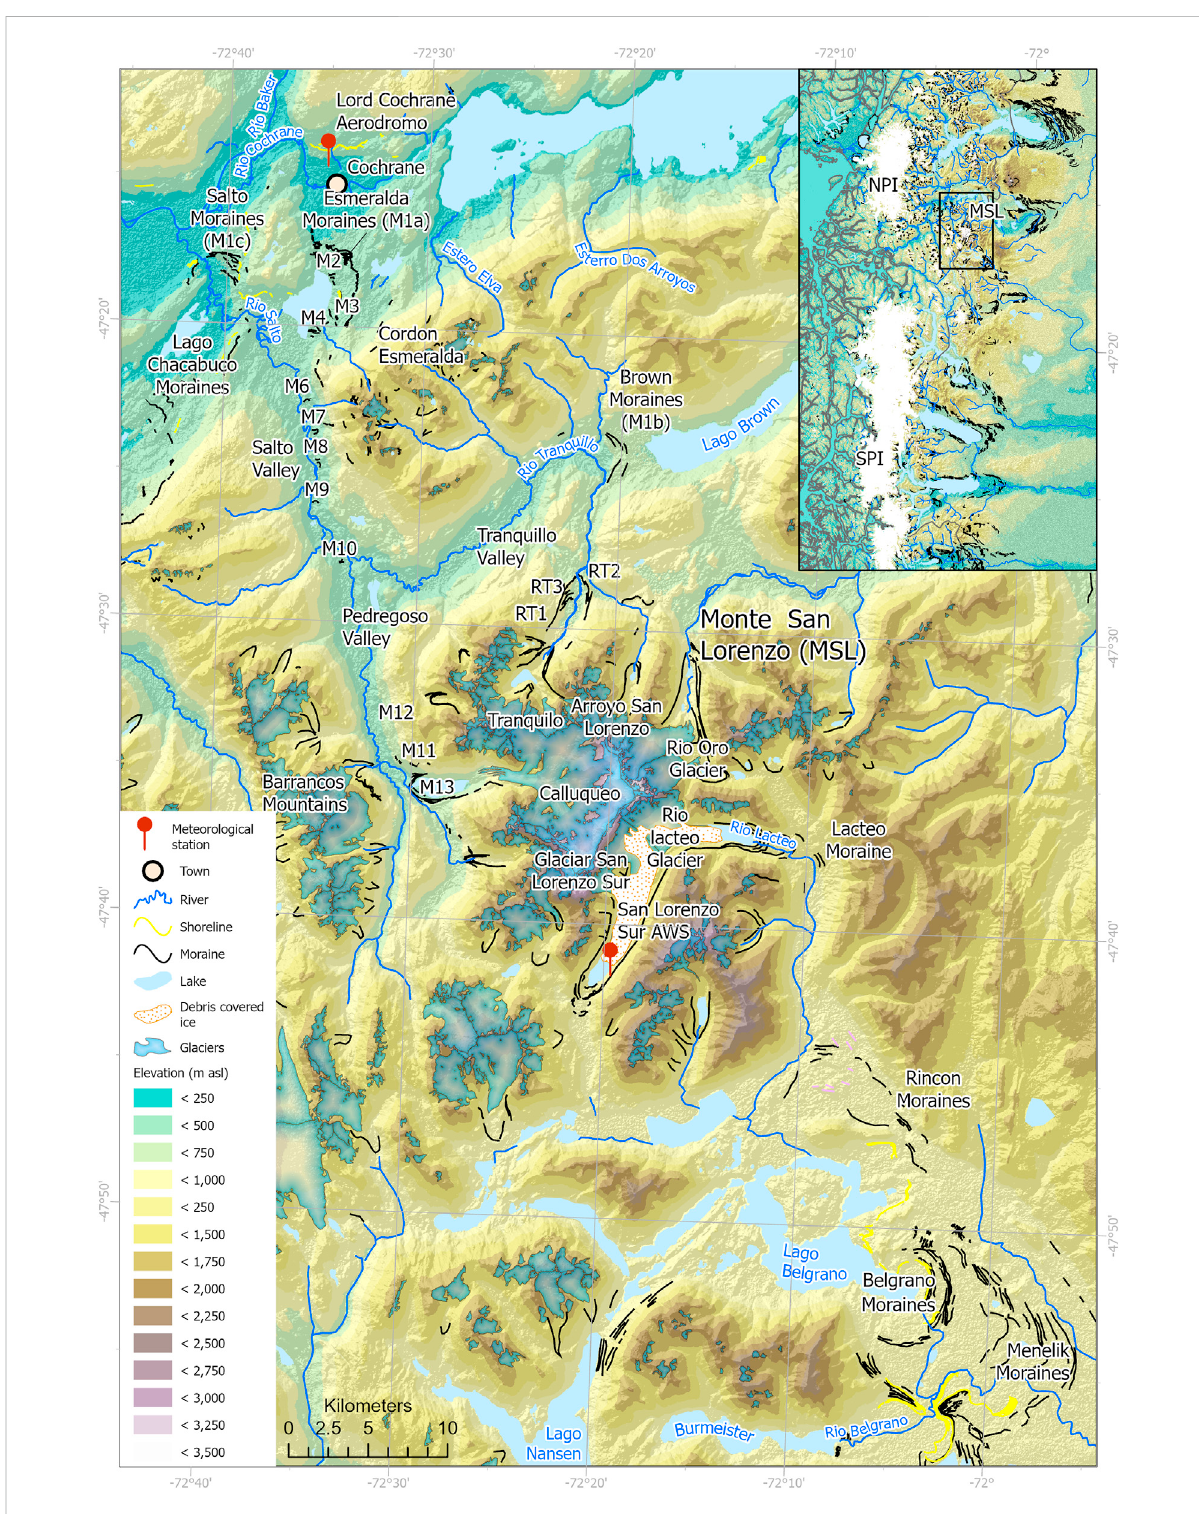
FIGURE 1 Map of the study area, with Monte San Lorenzo (MSL) and major placenames and geomorphological features mapped. Moraines, shorelines, rivers and lakes mapped in previous work (Davies and Glasser, 2012; Davies et al., 2018; 2020; Sagredo et al., 2018; Martin et al., 2019; 2022; Mendelová et al., 2020). For the inset, moraines and glaciers are from the compilation in Davies et al. (2020). Glacier outlines are derived from the RandolphGlacierInventoryv.6.0(RandolphGlacierInventoryConsortiumetal.,2017),withatimestampof31.05.2003.Insetshowsoverviewof Monte San Lorenzo (MSL), which lies to the southeast of the Northern Patagonian Ice fi eld (NPI) and northeast of the Southern Patagonian Ice fi eld (SPI). Moraine codes are after Martin et al. (2019), Mendelová et al. (2020), and Sagredo et al. (2018). AWS: Automatic weather